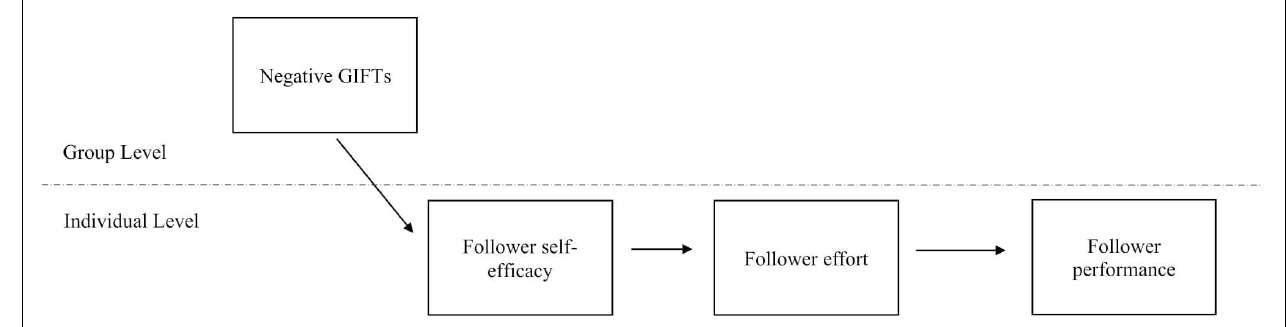
FIGURE 1 | Proposed multi-level model of negative